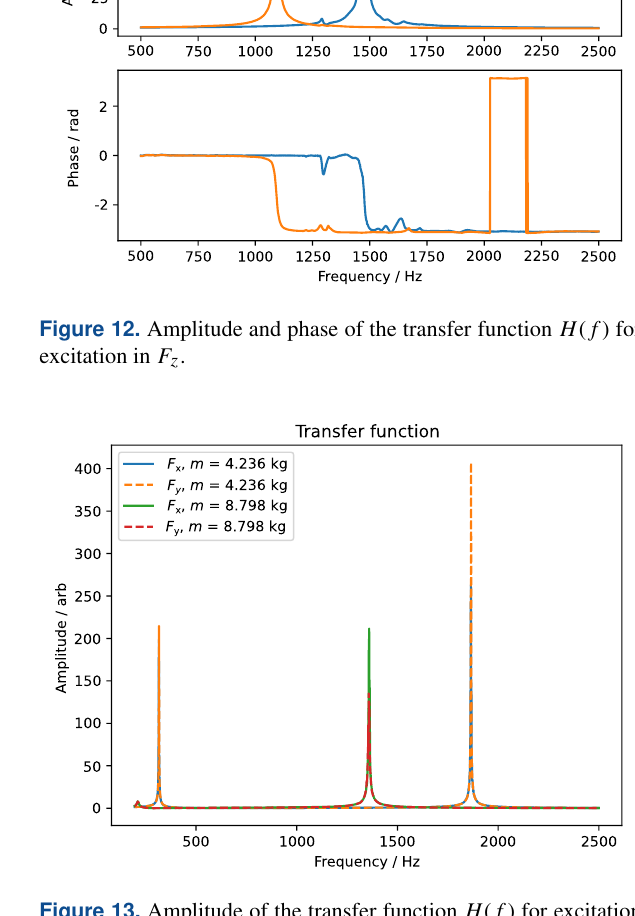
Figure 13. Amplitude of the transfer function H ( f ) for excitation in F x and F y